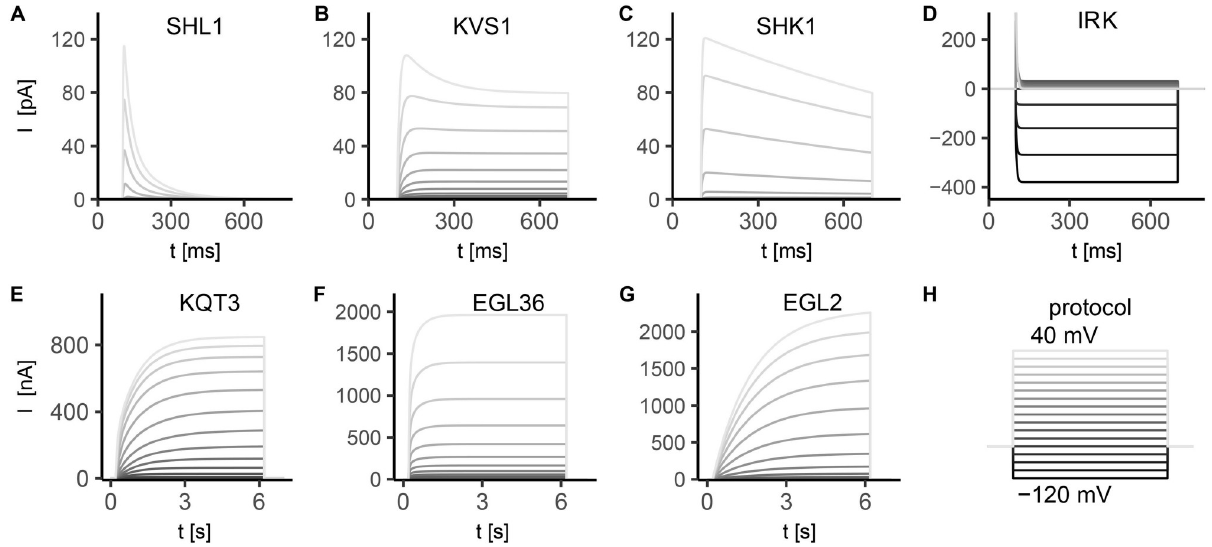
Fig 1. Simulated currents of the voltage-gated potassium channels SHL-1, KVS-1, SHK-1, IRK-1/3, KQT-3, EGL-36 and EGL-2. Potassium currents present two different timescales for activation: some of them have fast activation (panels A-D, t (panels E-G, � 100 ms < t < 2 s ). Stimulation protocol (sketched in panel H) consists in 10 mV voltage steps, from -120 mV to 40 mV. Each step m x lasts 600 ms for fast activating currents (panels A-D) and 6 s for slow activating ones (panels E-G). The holding potential is assumed equal to potassium reversal potential, i.e. V = − 80 mV. The currents are expressed in pA (panels A-D) or nA (panels E-G), depending on the experimental data used as h reference. The simulated currents in panels A-G are given by Eqs A5, A9, A14, A30, A21, A27, and A24 in S1 File, respectively, in which